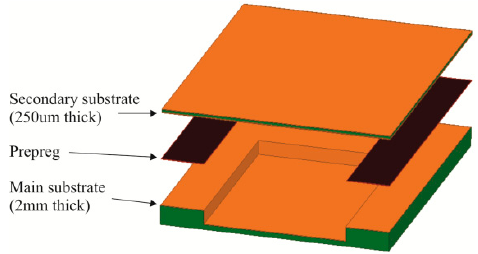
Figure 21. Stack of layers for the integrated empty substrate. FR4 substrates (green), Prepreg (dark red), and copper (orange).